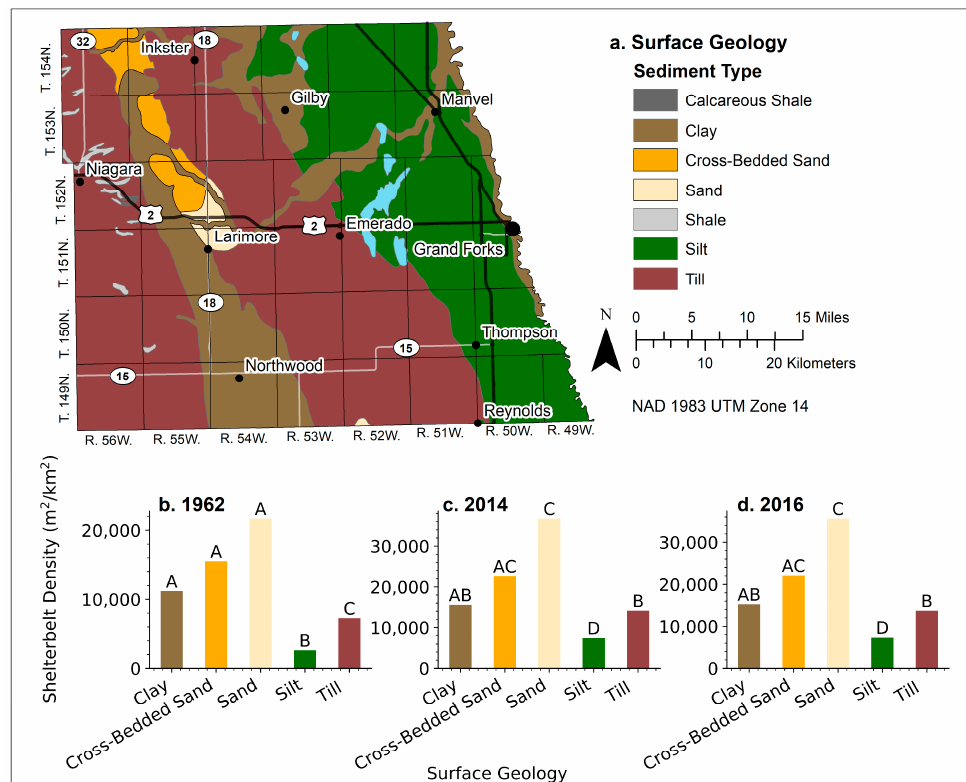
Figure 7. ( a ) Spatial arrangement of surface geology found in GFC. The mean shelterbelt density for the five prominent types of surface geology within GFC, using density values from the three years: ( b ) 1962, ( c ) 2014, and ( d ) 2016. The lettering placed above the bars depicts significance levels from the one-way analysis of variance at a 95% confidence interval, representing a significant difference in shelterbelt density when compared with the other types of surface geology.